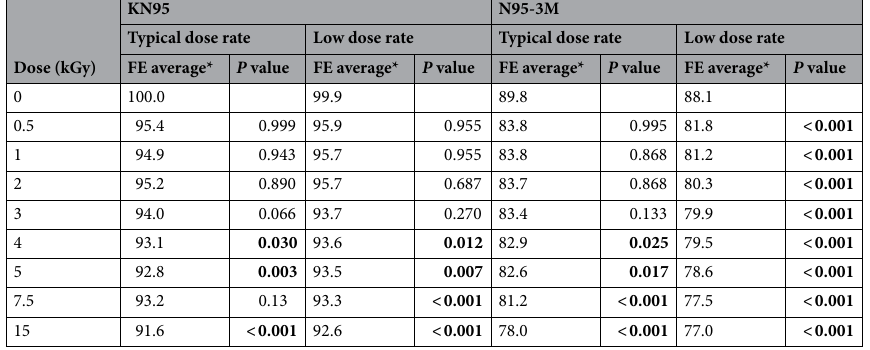
Table 1. Filtration efficiency of KN95 and N95-3M masks before and after gamma radiation dose of 0–15 kGy. *The FE average is either a mean FE value if FE variables at all particle sizes (0.3–5 µm) passed the normality test or a median FE value if FE variables failed the normality